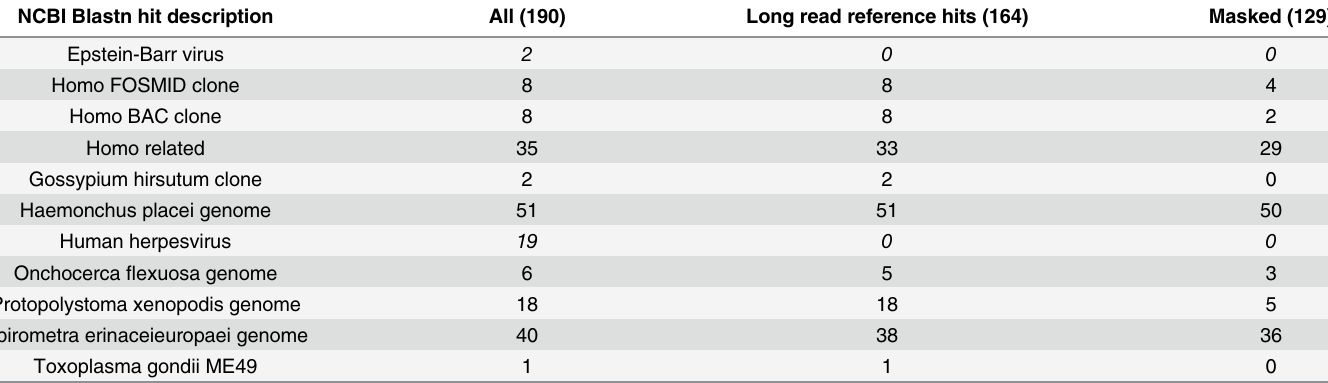
Table 4. Classification of the 190 un-mappable repeats with NCBI Blastn hits. The numbers in parentheses are the numbers of repeats in each category.